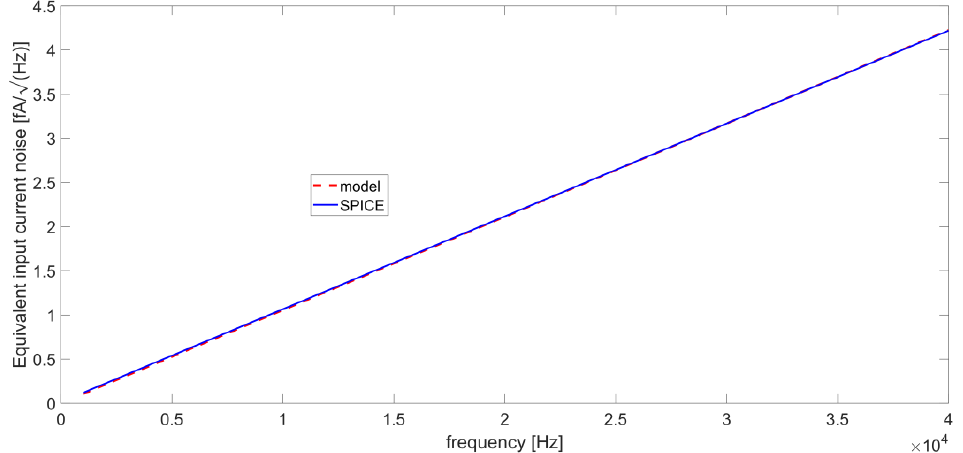
Figure 11. Fitting between the analytical model and SPICE simulations of the input equivalent noise current of the AD8067.